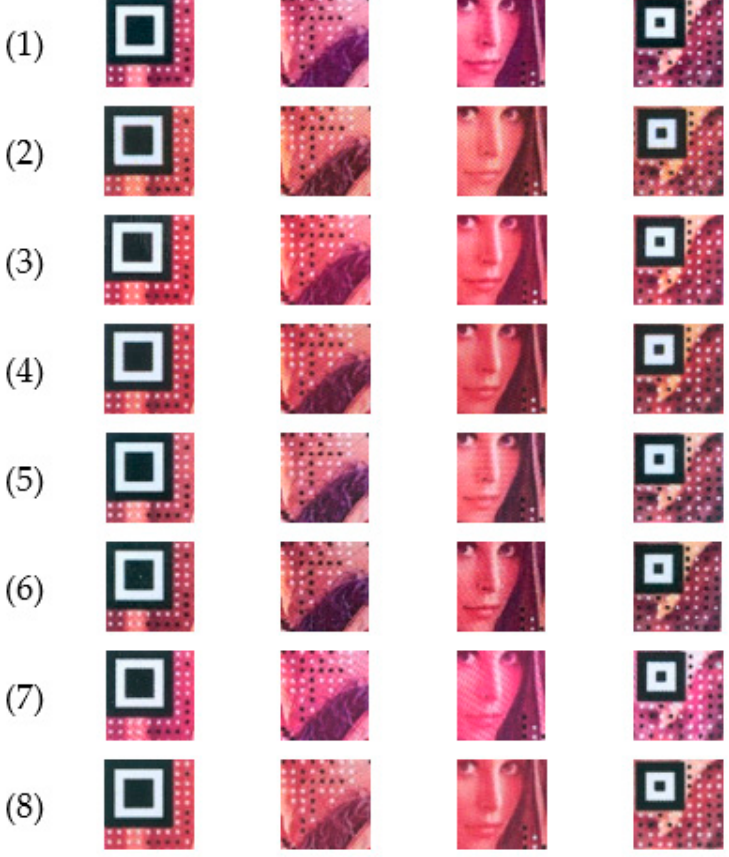
Figure 7. Image samples for color QR codes (see Table 2 for printer brands).